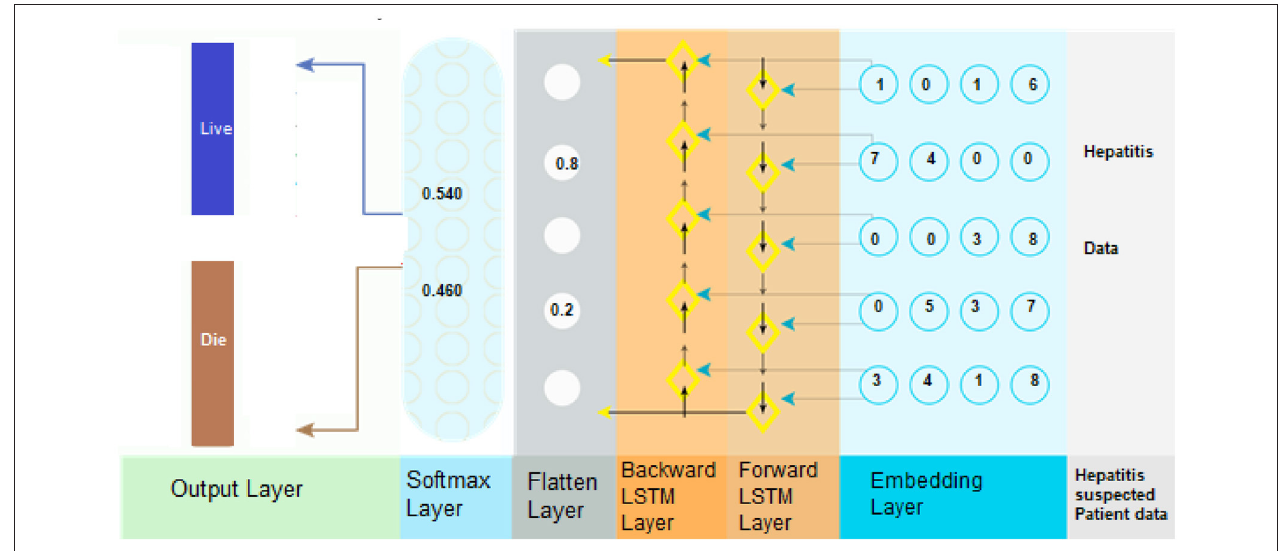
FIGURE 3 | BiLSTM is used for the hepatitis prediction system.